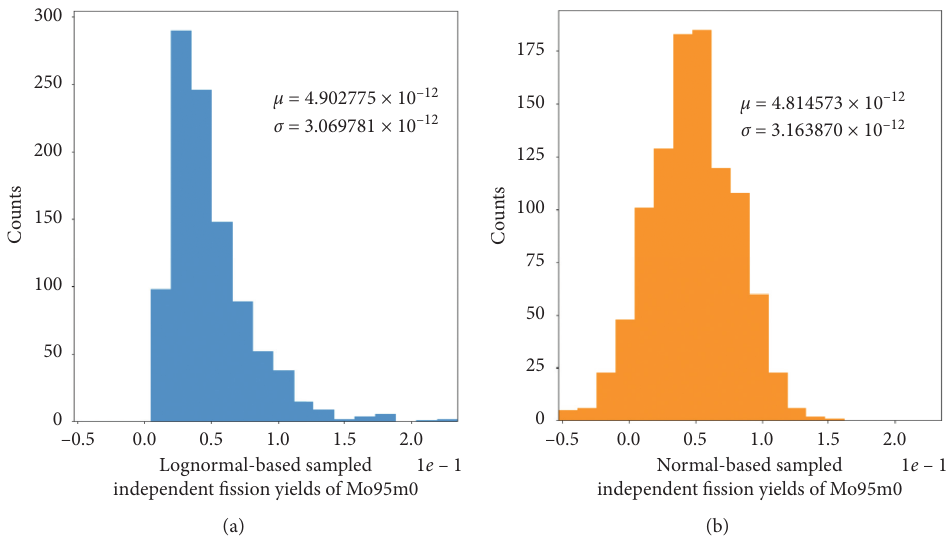
Figure 16: Histogram comparison of lognormal sampled (a) and normal sampled (b) independent fission yields samples of Mo95m0. This fission product has relative uncertainty of 65.7%. The text presents the sampled mean value and STD and the population mean and STD for Mo95m0 are 4 . 939650 × 10 − 12 and 3 . 161380 × 10 − 12 .